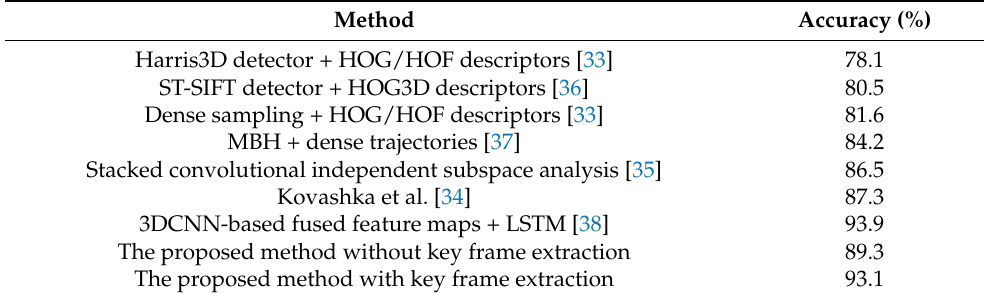
Table 2. The performance evaluation of different methods for action recognition on the UCF Sports dataset.